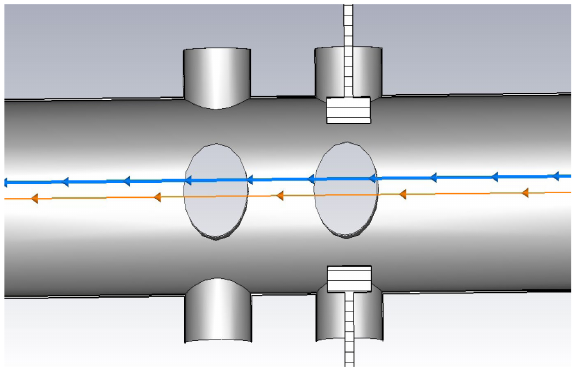
FIG. 5. Half of the 3D CST-model of